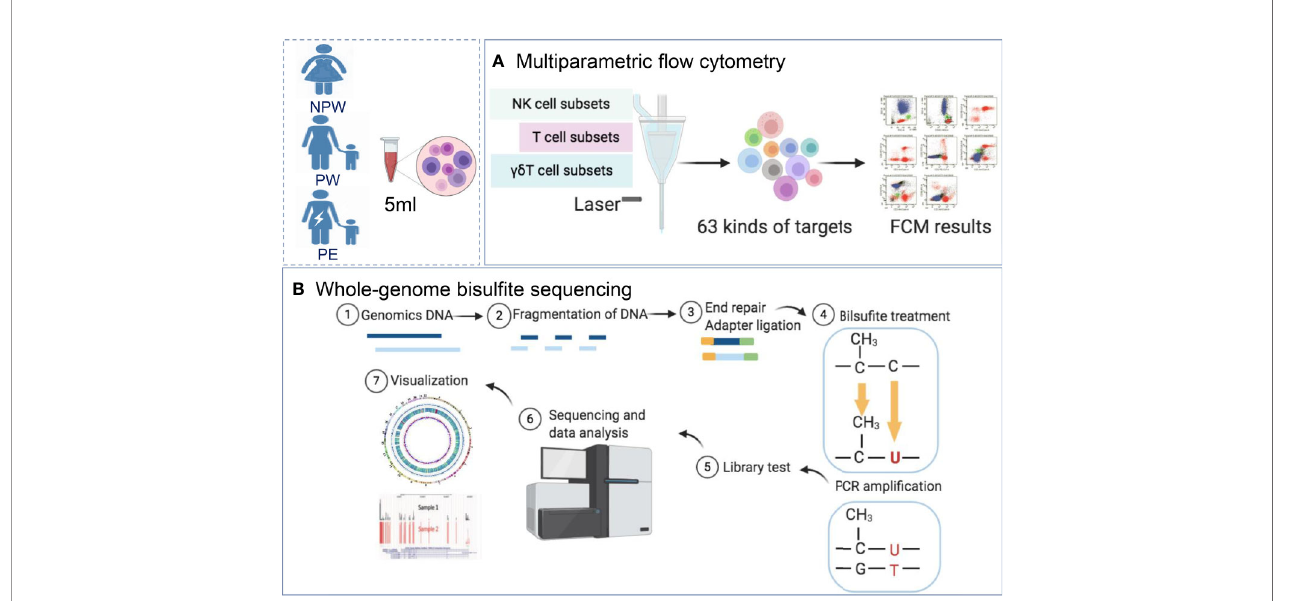
FIGURE 1 | Study design. (A) Women were recruited into the NPW (n = 50), PW (n = 50) and PE (n = 14) groups. A total of 63 immunological parameters, including T cell, NK cell and gd T cell subsets in peripheral blood, were assessed using multiparameter fl ow cytometry. (B) Whole-blood DNA methylation in the NPW (n = 5), PW (n = 5) and PE (n = 5) groups was detected using WGBS. NPW, nonparous woman; PW, pregnant woman; PE, preeclampsia; WGBS, whole-genome bisul fi te sequencing.